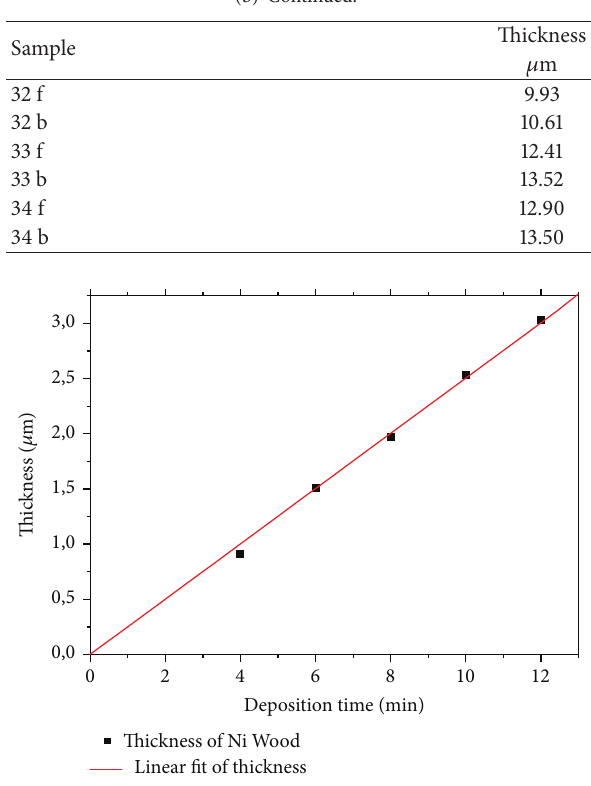
Figure 1: Ni Wood thickness as a function of the 𝑡